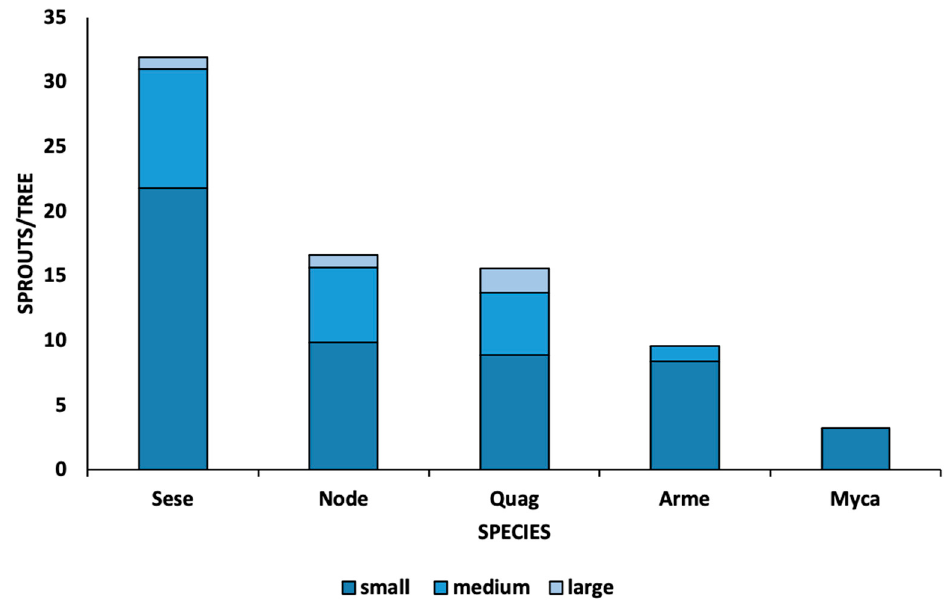
Figure 2. Post fire sprouting by size-class following a high severity crown fire in Big Basin Redwoods State Park, California. Sese = Sequoia sempervirens (D. Don) Endl.; Node = Notholithocarpus densiflorus (Hook. & Arn.) Manos; Psme = Pseuotsuga menziesii (Mirb.) Franco; Quag = Quercus agrifolia Nee.; Myca = Myrica californica (Cham. & Schltdl.) Wilbur; Arme = Arbutus menziesii Pursh. Height classes were defined as small (0.0–0.5 m), medium (>0.5–1 m), and large (>1 m).